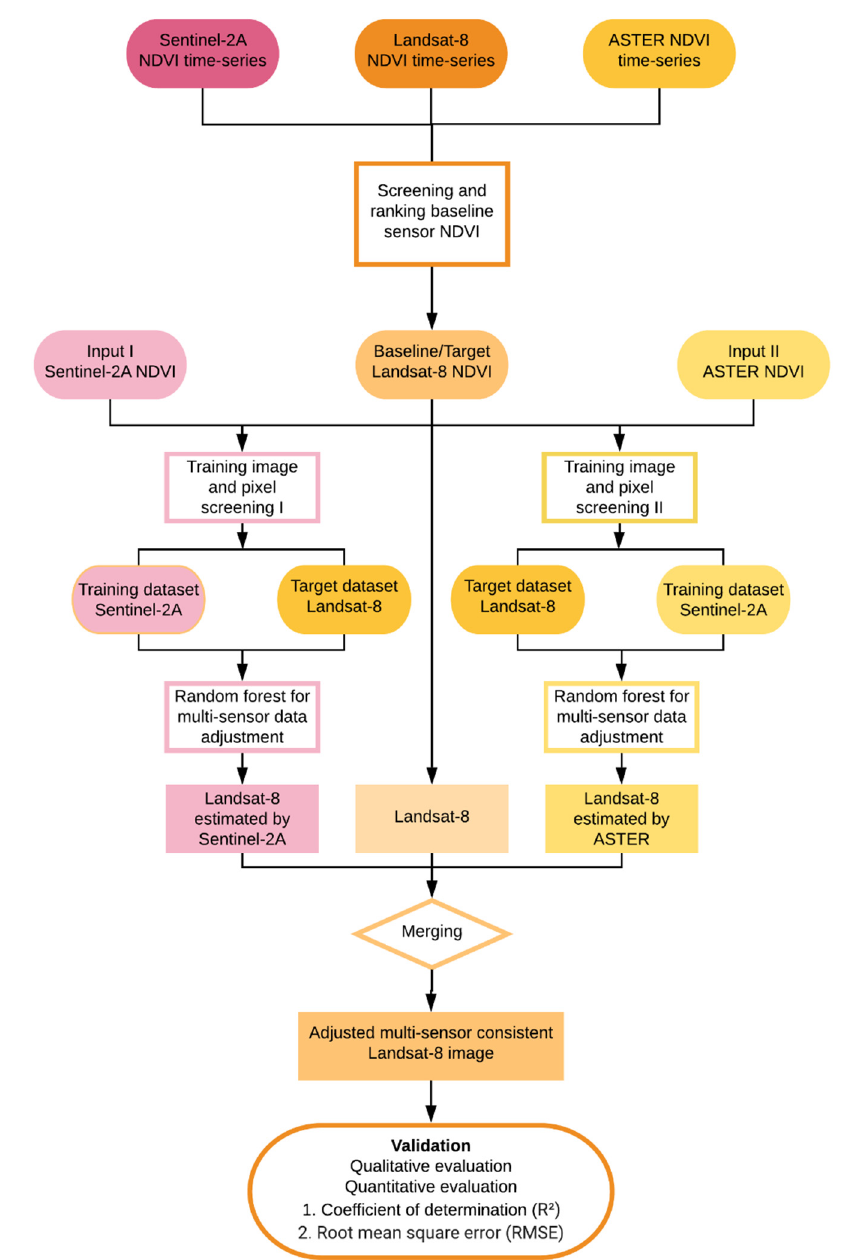
Figure 4. Schematic flowchart of the virtual constellation process.